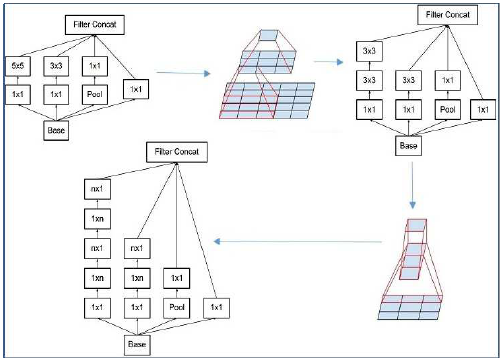
Figure 2. Convolution of multi-channeled image